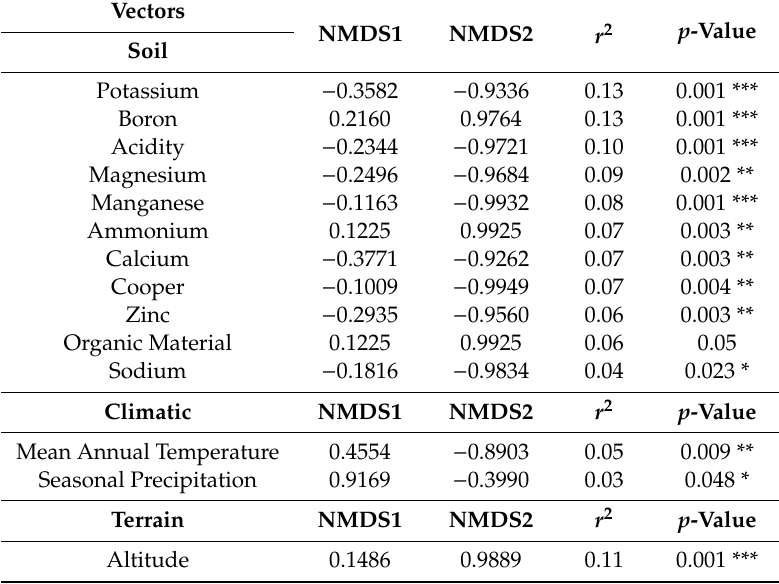
Table 2. Factors and vectors that significantly influenced the grouping of the forest plots of the eastern mountain ranges of southern Ecuador.